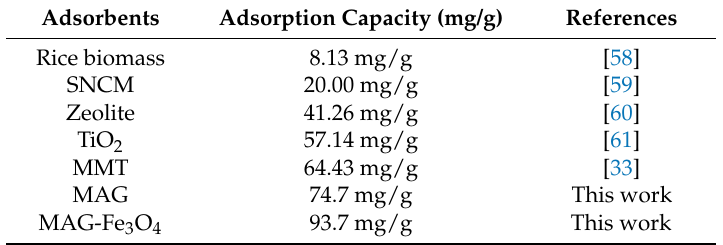
Table 3. Comparison of MB adsorption capacity with other reported systems.